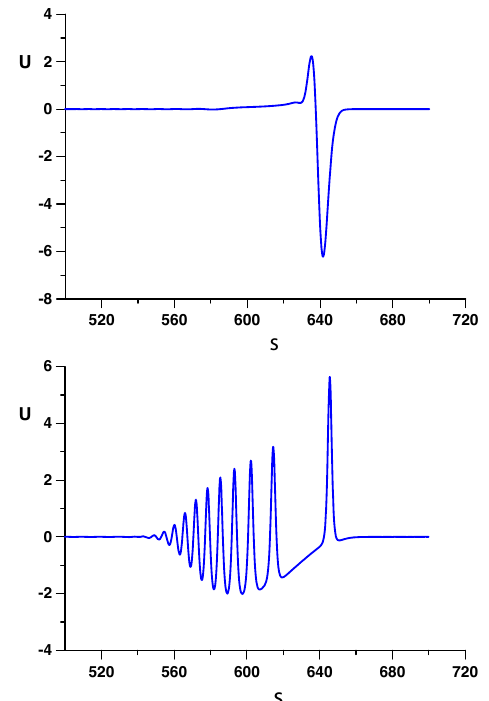
Fig. 3. Numerical simulation of the vKdV equation (3) with δ = 1 and as α varies from − 1 to +1. The upper panel is when α = 0 and the lower panel is when α = 1. The simulation shows a strong deformation of the initial solitary wave of depression at α = 0, followed at α = 1 by the emergence of a number of solitary waves of elevation riding on a negative